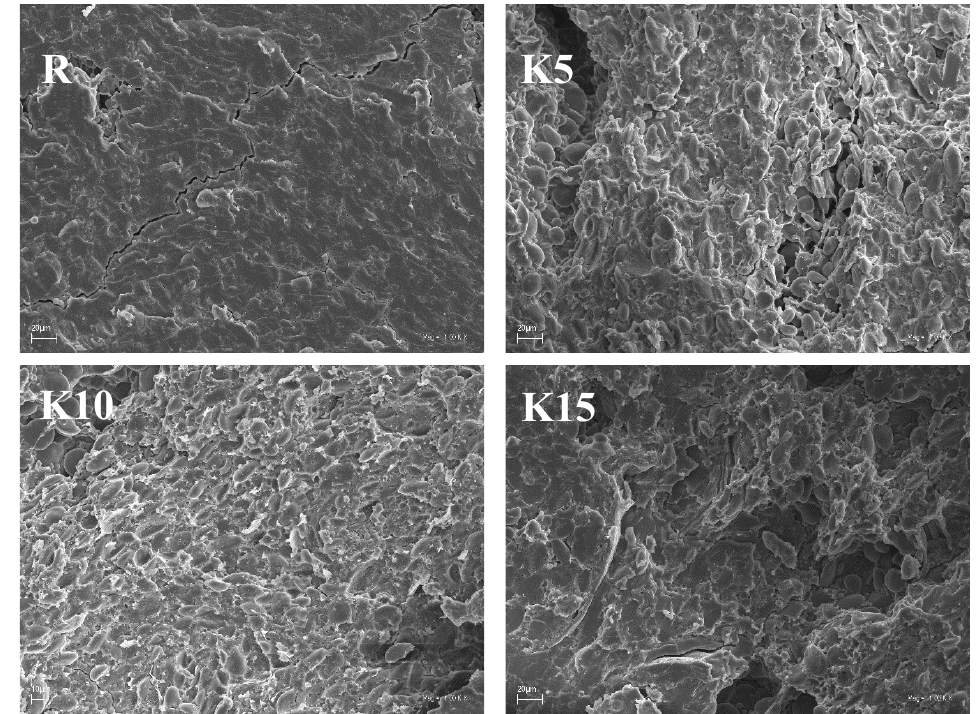
Figure 2. Scanning electron microphotographs of pasta. R—reference pasta without the addition of kiwiberry lyophilizate; K5, K10, and K15—pasta contained 5%, 10%, and 15% kiwiberry